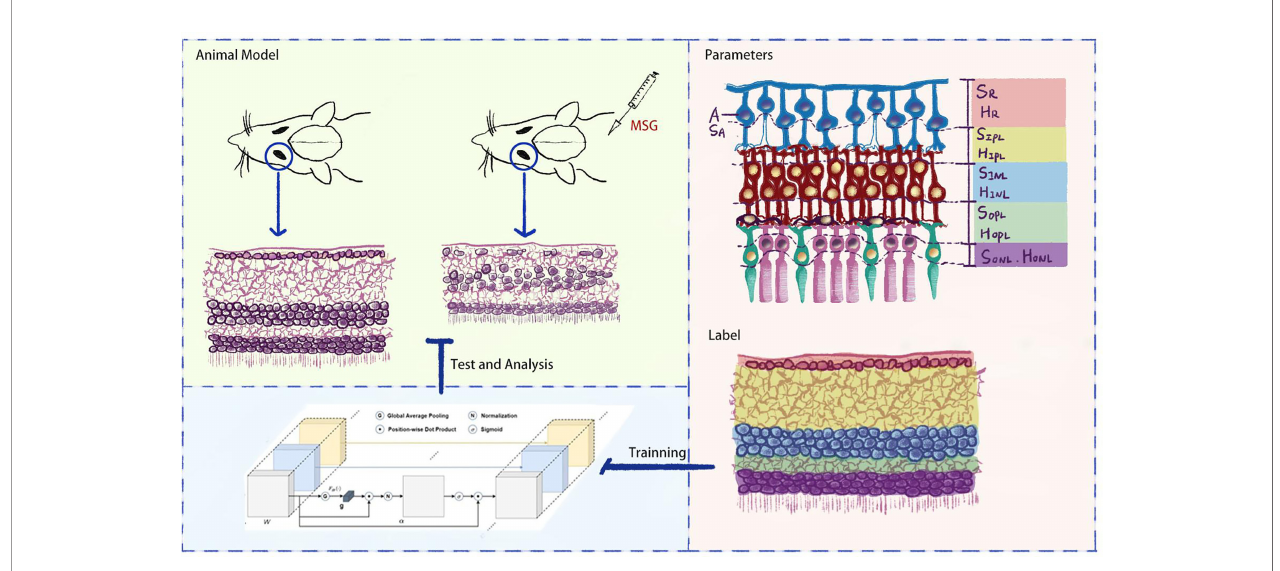
FIGURE 1 | Flowchart of the